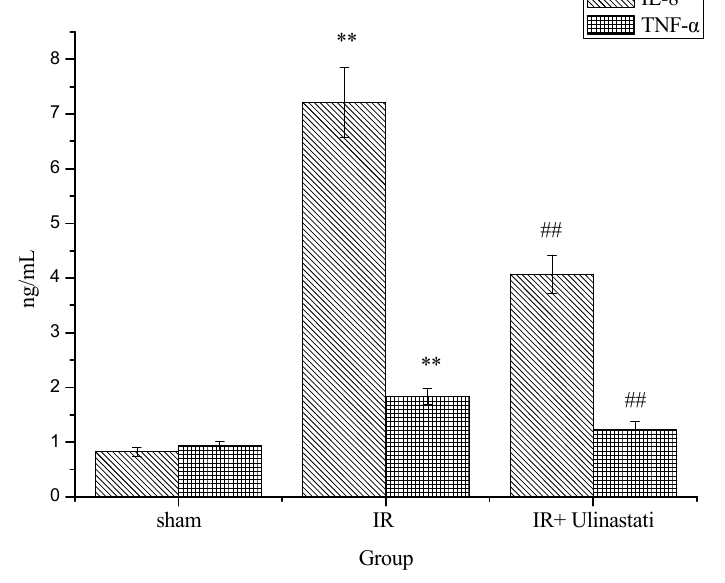
Figure 2. Effect of ulinastatin on serum IL-8 and TNF- α levels in three groups